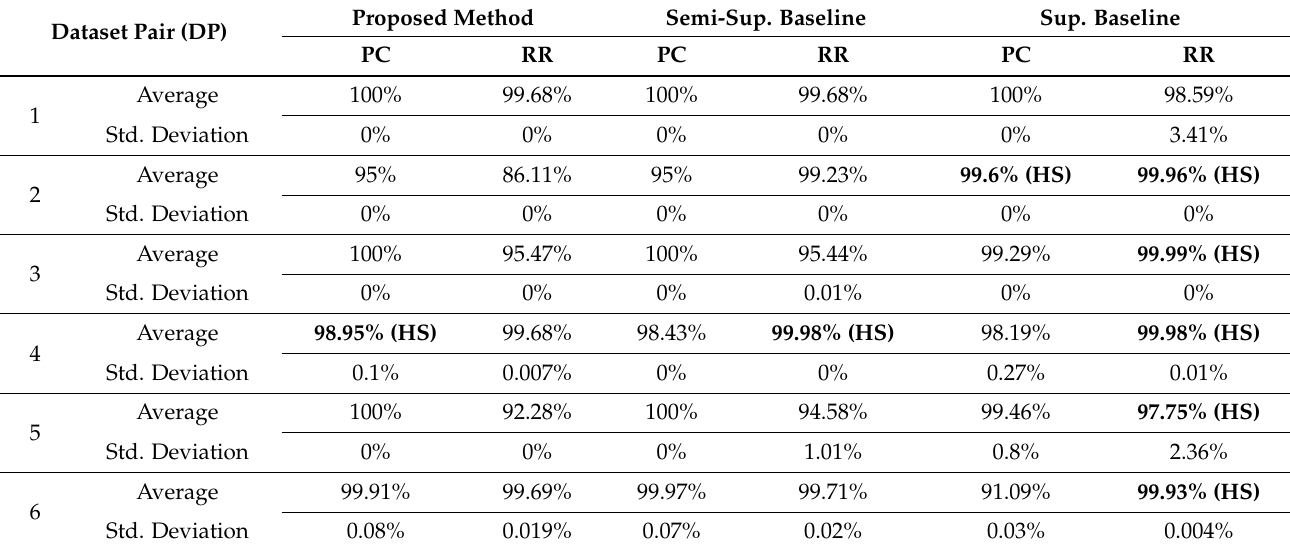
Table 4. Comparative Results of Extended DNF BSLs. Bold values are (at least) weakly significant, with significance levels (WS, SS, or HS) in